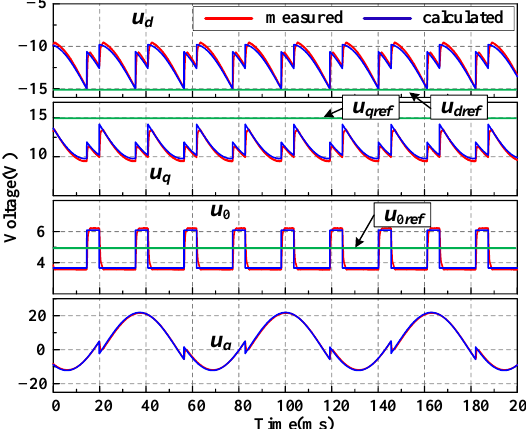
Figure 9. Verification of open winding inverter nonlinearity model.